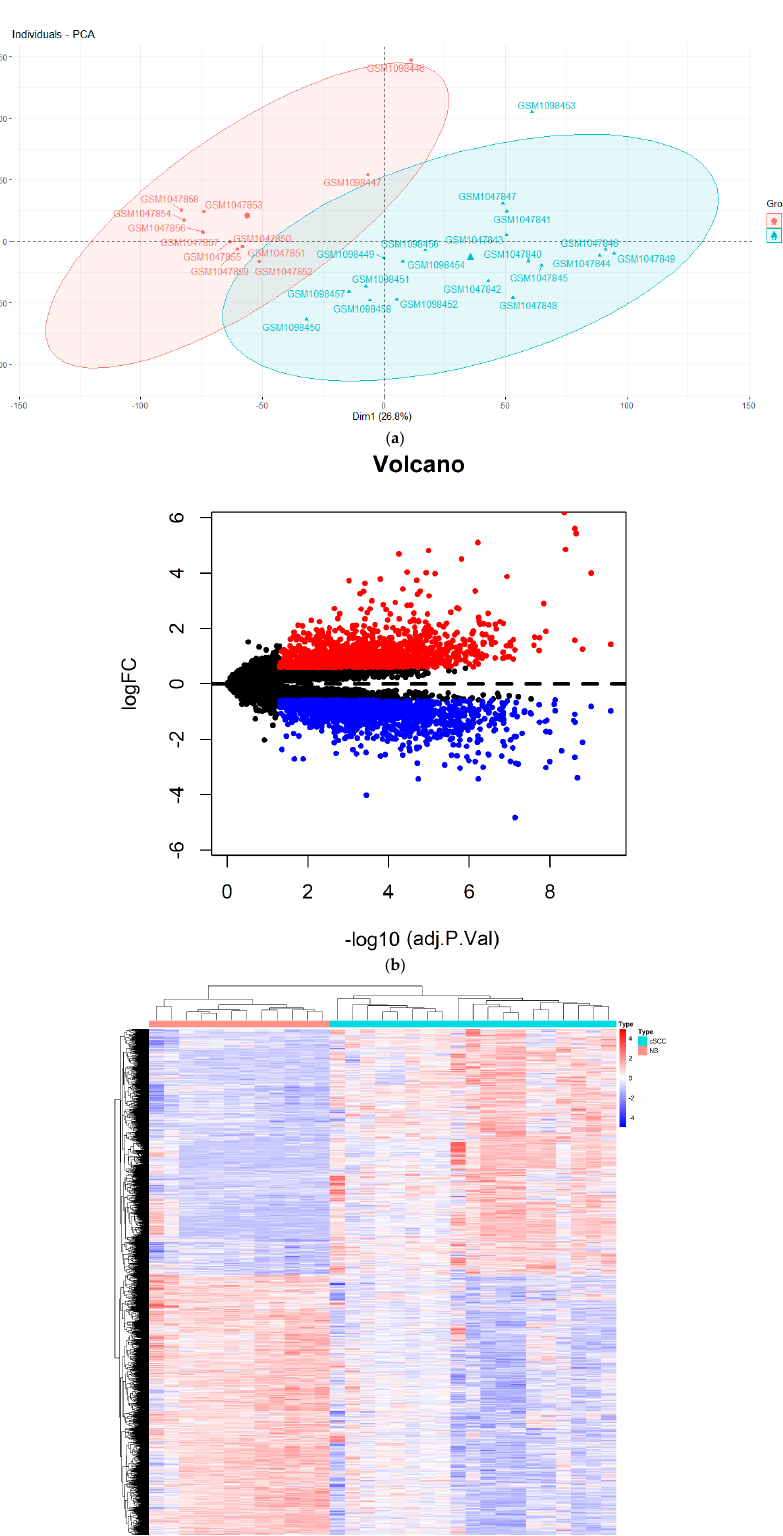
( c ) Figure 1. Differentially expressed analysis between cSCC and NS tissues from GSE42677 and GSE45164 datasets. ( a ) The Figure 1. Differentially expressed analysis between cSCC and NS tissues from GSE42677 and GSE45164 datasets. ( a ) The principal component analysis (PCA) of the selected 19 cSCC and 12 NS tissues; ( b ) volcano plots showing DEGs. The red dots represent an upregulated expression and the blue dots represent downregulated DEGs; ( c ) cluster analysis (heatmap) principal component analysis (PCA) of the selected 19 cSCC and 12 NS tissues; ( b ) volcano plots showing DEGs. The red between 19 cSCC and 12 NS tissues. The red stripes display upregulation while the blue stripes display the downregula- tion of genes. DEGs: differential expression genes. dots represent an upregulated expression and the blue dots represent downregulated DEGs; ( c ) cluster analysis (heatmap) 2.3. Construction of the cSCC-Associated lncRNA-miRNA-mRNA Network between 19 cSCC and 12 NS tissues. The red stripes display upregulation while the blue stripes display the downregulation Due to the absence of miRNA information, the miRcode database [23] (http://www.mircode.org/, accessed on 1 September 2020) was used to predict the targeted of genes. DEGs: differential expression miRNAs of DElncRNAs. According to the miRTarBase [24] (http://mirtar- base.mbc.nctu.edu.tw/, accessed on 1 September 2020), miRDB [25] (http://www.mirdb.org/, accessed on 1 September 2020) and TargetScan [26] (http://www.targetscan.org/), the DEmRNA-miRNA interaction pairs were obtained. Only the overlapping of the interaction pairs supported by all databases was retained to create the miRNA-mRNA pairs. Subsequently, the correlation between DElncRNAs and DEmRNAs was analyzed by Pearson’s correlation coefficient (PCC) with the threshold of the PCC value r > 0.4 and p < 0.05 indicating a strong correlation. Finally, the remaining